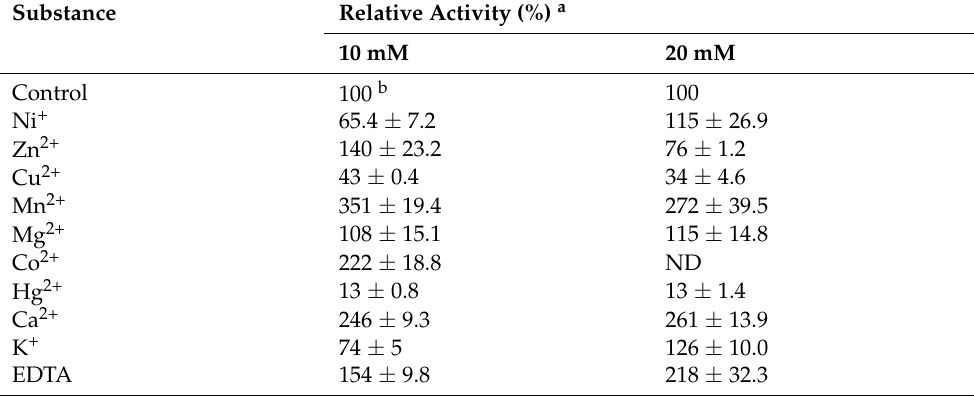
Table 3. Effect of 10 mM and 20 mM metal ions and chemical reagents on the MG9373 activity.